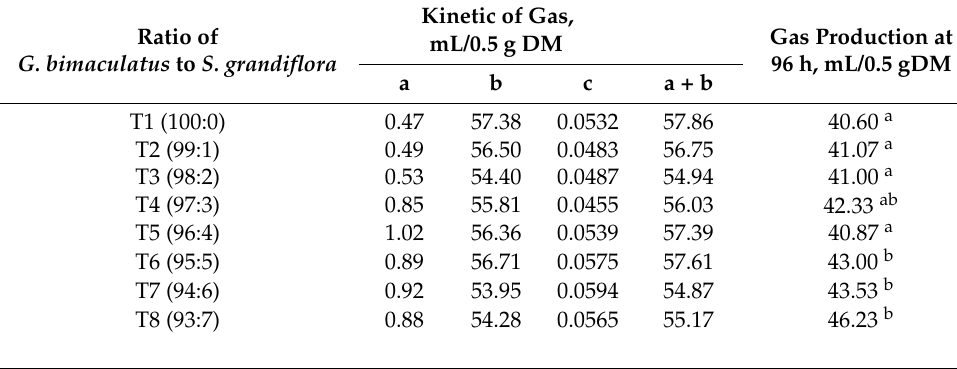
Table 3. Effect of manipulation of in vitro protein degradation from G. bimaculatus powder combined with phytonutrients from S. grandiflora on kinetic of gas and gas production. Ratio